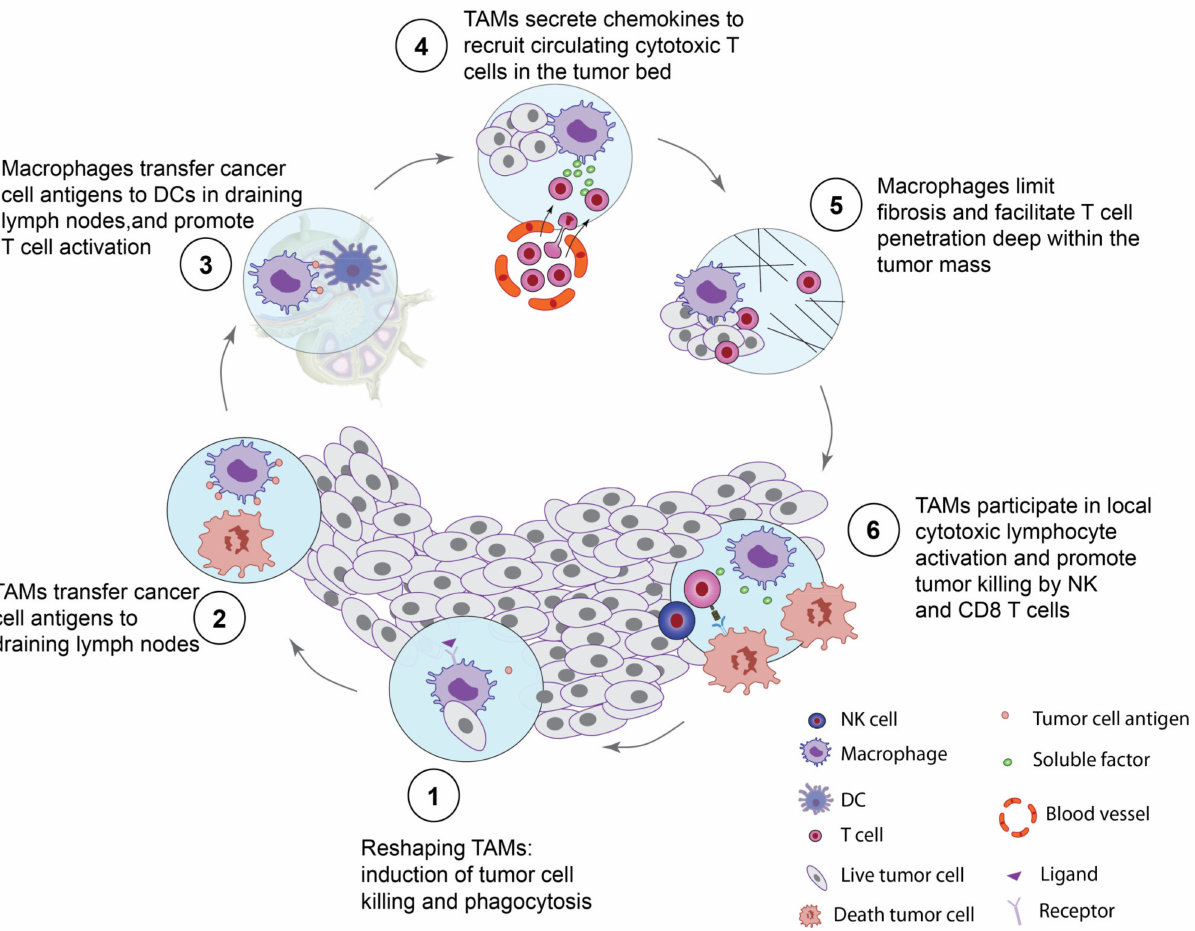
Figure 1. Macrophages can act as key effectors in the cancer-immunity cycle. (1) TAMs can be reprogrammed to initiate the cycle by killing tumor cells through production of ROS/NO or in a contact-dependent manner. Cytotoxic TAMs would induce the release of tumor (neo-)antigens. (2–3) Phagocytosis of dead cancer cells by TAMs and transfer of cancer-associated antigens to dendritic cells (DC), in the TME, or after migration in the draining lymph nodes (LN). Subcapsular CD169 + macrophages in LN have also been reported to transfer cancer-associated antigens to DC. This leads to proficient activation of tumor-specific cytolytic CD8 T cells. (4) TAMs can secrete CXCL9, CXCL10, CXCL11, the ligands of CXCR3, and actively recruit tumor-specific CD8 T cells from the circulation. (5) TAMs can produce selective enzymes that loosen up the extracellular matrix, limit fibrosis, which in turn facilitates T cell infiltration deep within the tumor mass. (6) TAMs can potentiate the cytotoxic functions of NK and CD8 T cells. Altogether, this revisited model provides the rationale for targeting macrophages, which, by boosting different steps of the cancer-immunity cycle, will accelerate the generation of an anticancer response. This figure is adapted from